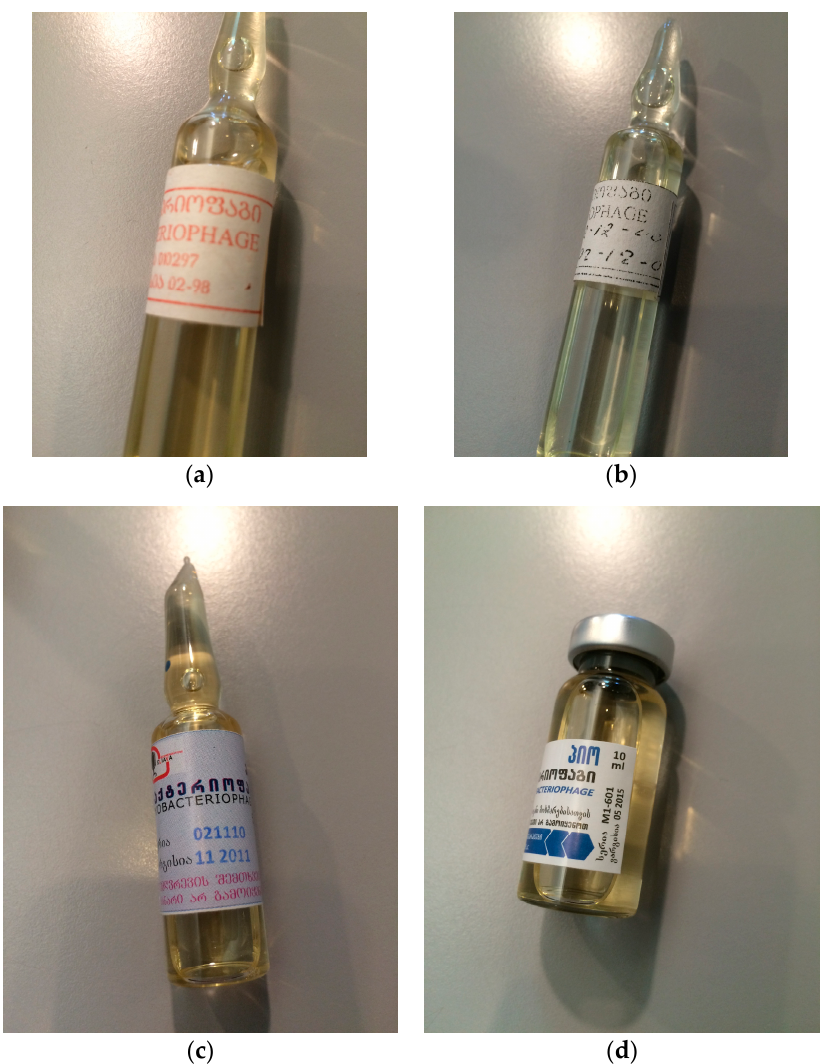
Figure 1. The four batches of pyophage (PYO) cocktail investigated here. The glass ampoules are dated ( a ) 1997; ( b ) 2000; ( c ) 2010 and ( d ) 2014.